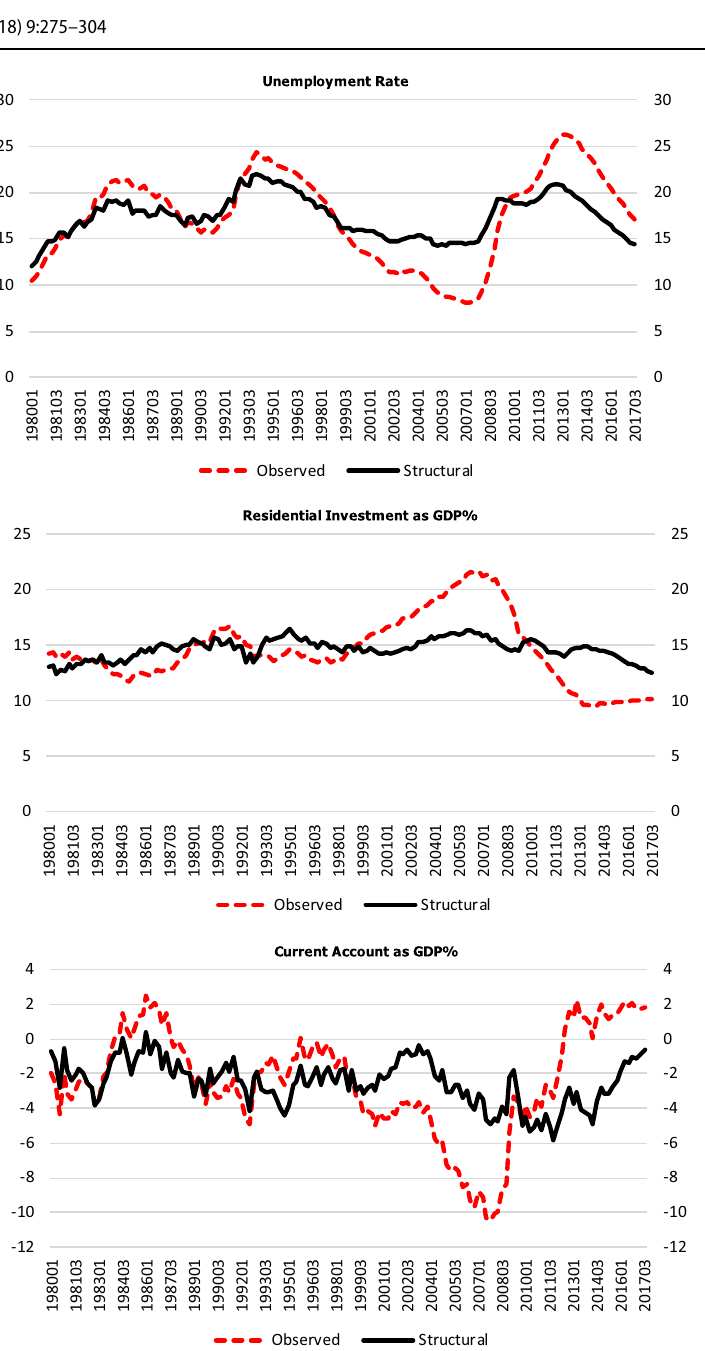
Fig. 6 Decomposing the observed variables. Source of data : author’s